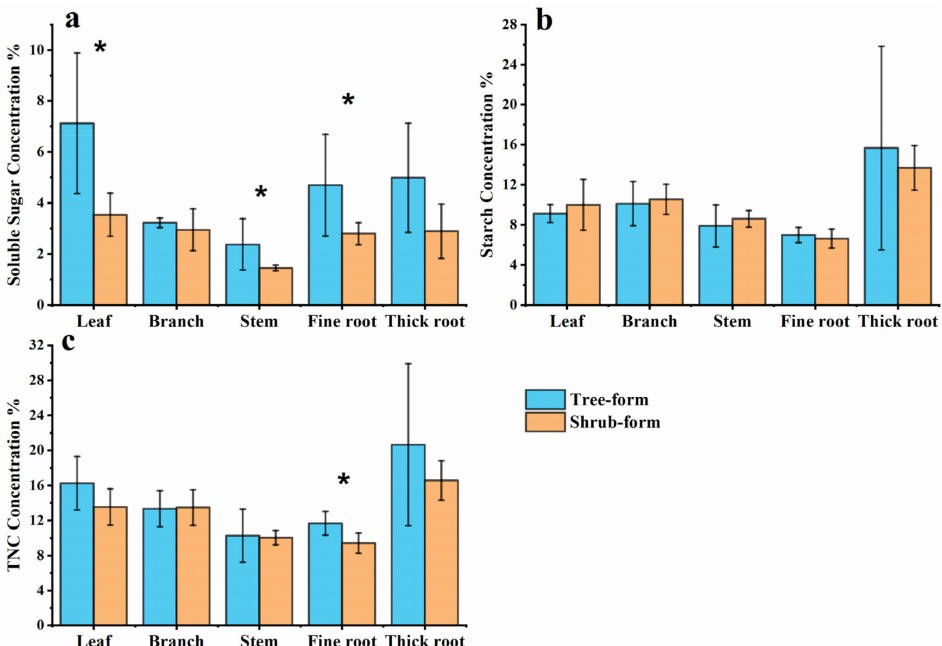
Figure 6. Effects of growth form on NSC concentration in adult trees/shrubs. Changes of ( a ), soluble sugar, ( b ), starch and ( c ), TNC concentration of each organ. MANOVA shows significant differences between the two growth forms (*, p <